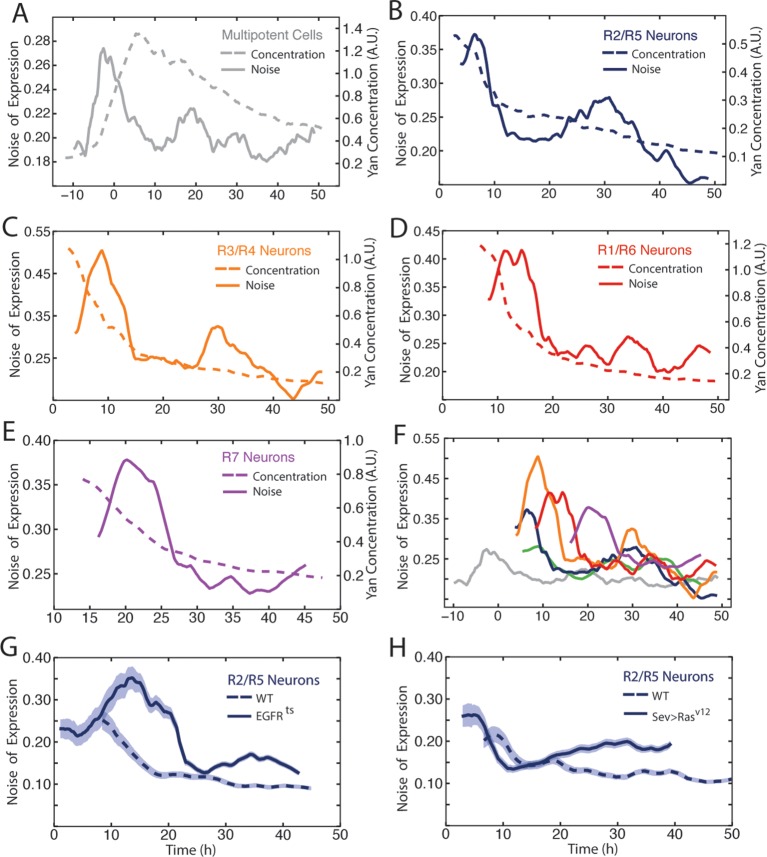
Noise in Yan-YFP expression is highly dynamic.Moving averages of Yan-YFP levels and noise (detrended fluctuations) for (A) progenitors, (B) R2/R5, (C) R3/R4, (D) R1/R6, and (E) R7 cells. (F) Comparative noise dynamics for all cells analyzed in (A–E). (G) Moving averages of Yan-YFP noise (coefficient of variation) in R2/R5 cells sampled from wildtype and EGFRts mutant eyes at the non-permissive temperature. Shown with shading is the standard error of the mean for each moving average. (H) Moving averages of Yan-YFP noise (coefficient of variation) in R2/R5 cells sampled from wildtype and sev>Rasv12 mutant eyes. Shown with shading is the standard error of the mean for each moving average.